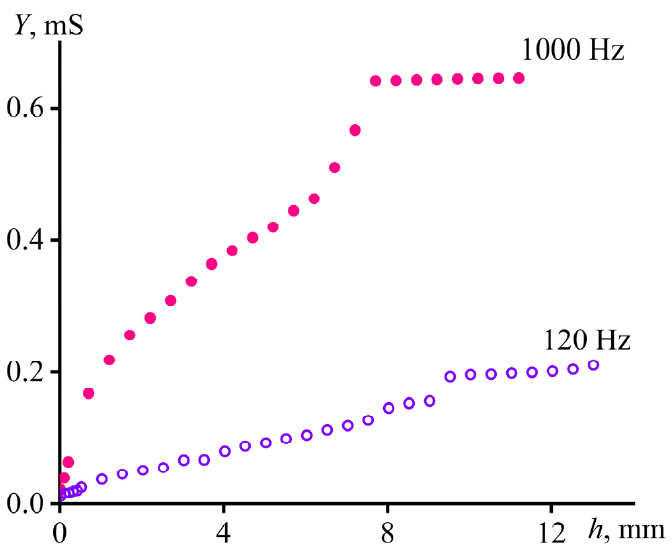
Figure 4. Dependences of the admittance of a cell with saturated NaCl solution on the immersion depth of a carbon filament. The second electrode was a carbon fiber bundle immersed in the solution for 25 mm. The alternating current frequency is indicated near the curves.